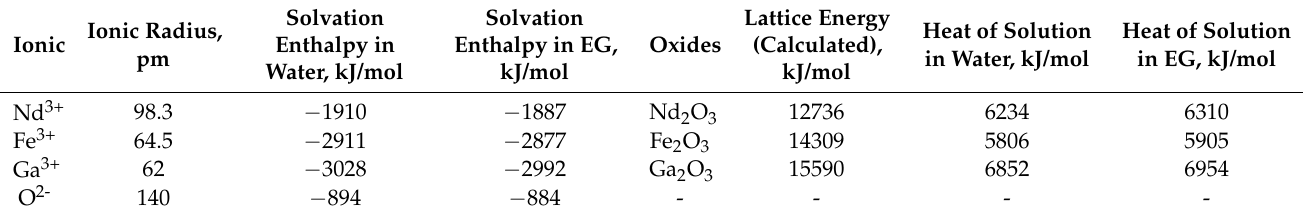
Table 3. Ionic radius and solvation enthalpy of ions, lattice energy, and heat of solution of the oxides